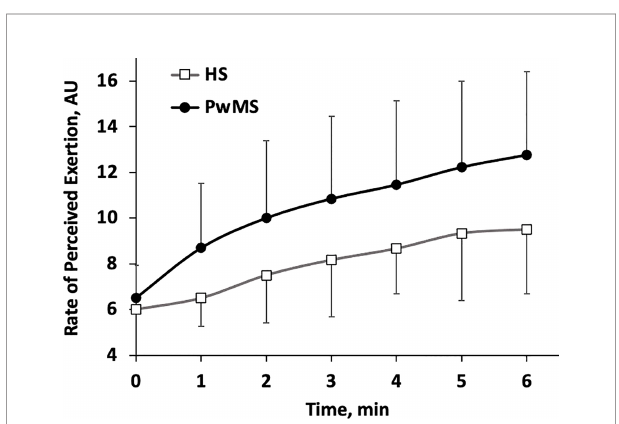
FIGURE 3 | Rate of Perceived Exertion (RPE) scores relative to the lower limbs (m±SD). Time course for each minute of the 6MWT. HS, Healthy Subjects; PwMS, Persons with Multiple Sclerosis. Black line and close circles: PwMS; grey line and open squares: HS.